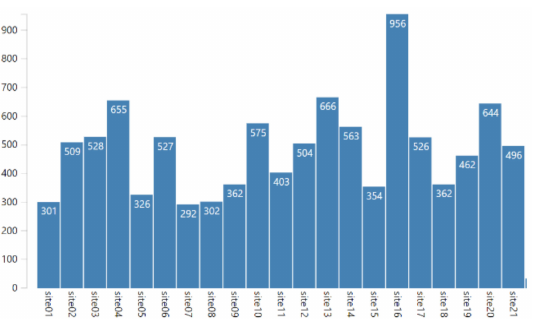
Figure A2. Distributions of the Study Variables and Testing the Model Assumptions.